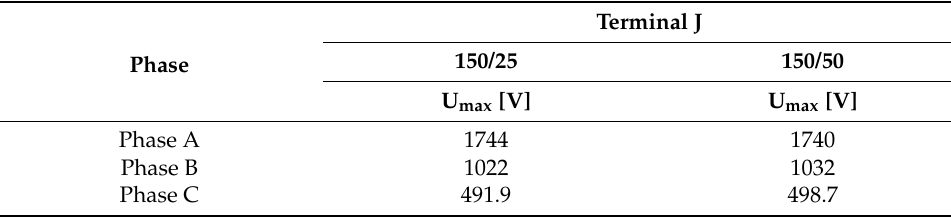
Table 7. Maximum overvoltages for different cross-sections of cable